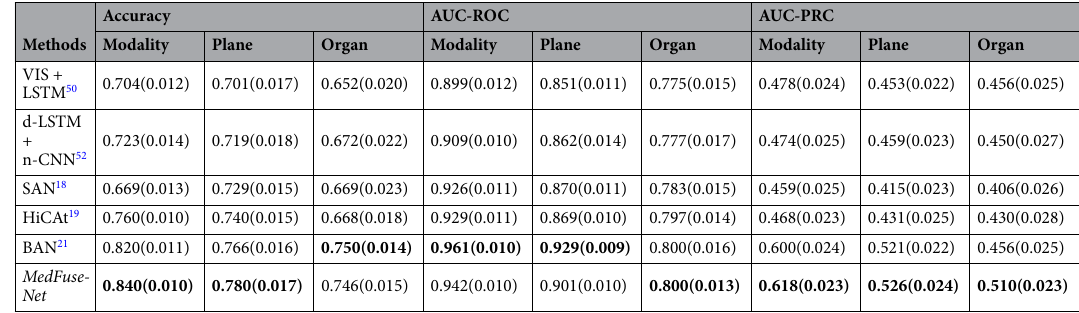
Table 4. Comparison of MedFuseNet with the baseline models on MED-VQA answer classification dataset.